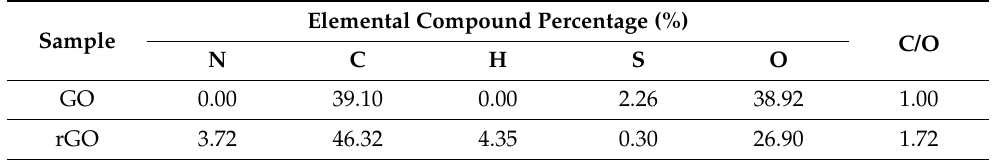
Table 5. GO and rGO composition measured by elemental analysis.